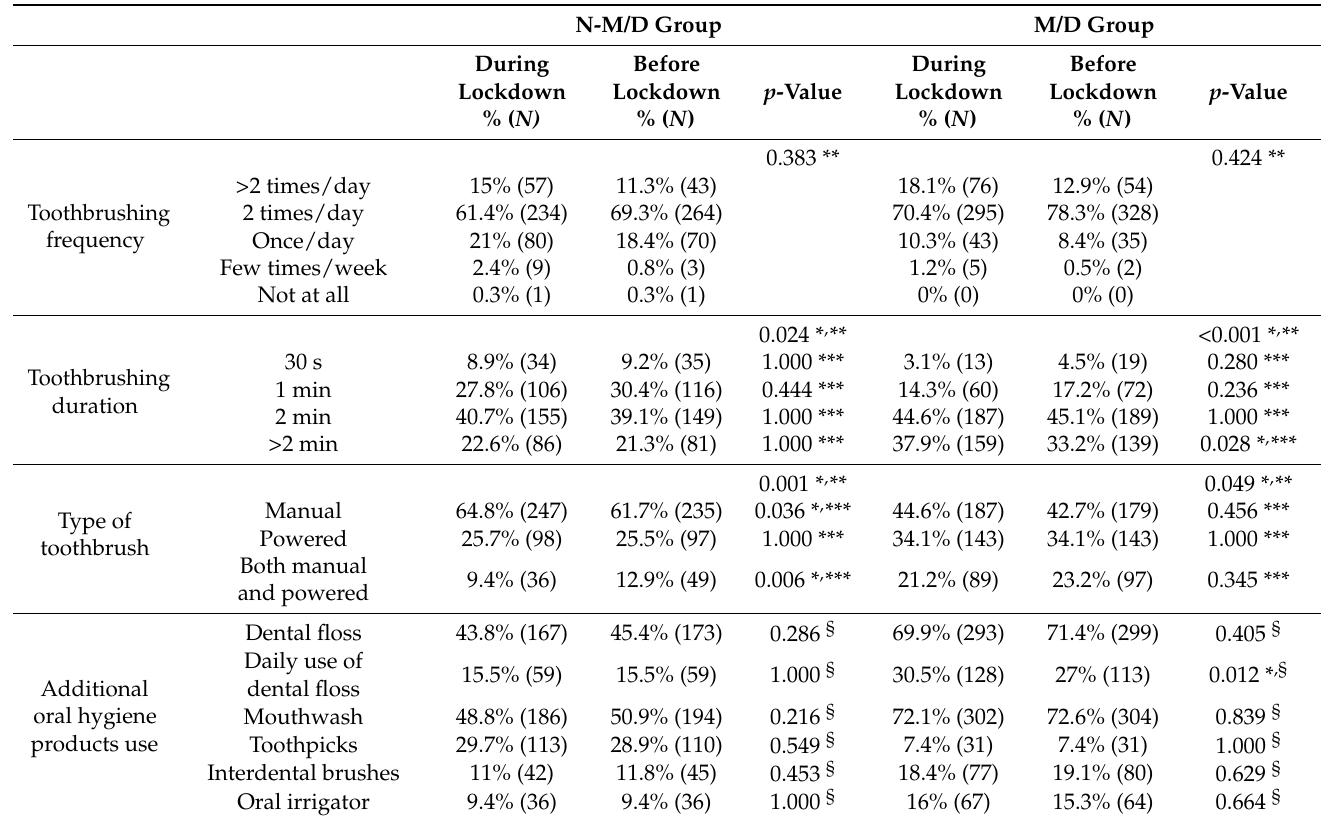
Table 1. Oral hygiene changes between pre-lockdown and during the COVID-19 lockdown, among medical/dental professionals and the general